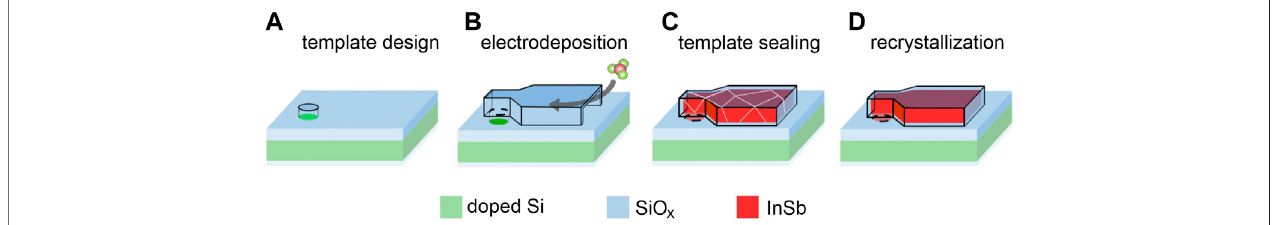
FIGURE 1 | Proposed process fl ow for InSb integration on Si. Conductive Si substrate with surrounding SiO x insulation (A) Conductive Si substrate with surrounding SiOx insulation and (B) 3D template is immersed in the electrochemical cell. (C) After electrochemical deposition of polycrystalline InSb, the template is sealed. (D) Melting and recrystallization to form a InSb singe crystal on